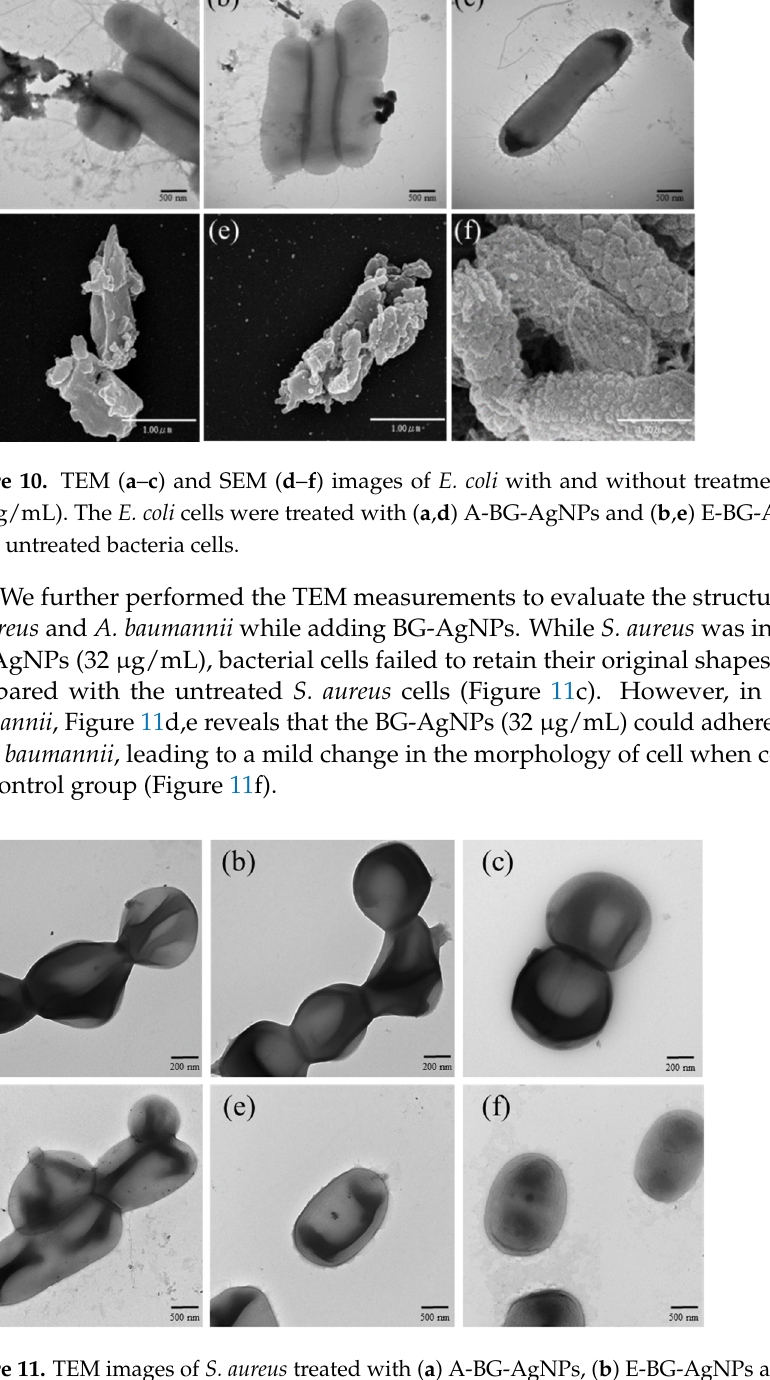
Figure 12. ( a – c ) Bright-field and ( d – f ) fluorescence images of E. coli incubated with ( a , b ) A-BG- AgNPs and ( b , e ) E-BG-AgNPs, and ( c , f ) show untreated bacteria after DCFH-DA treatment. Hemolytic evaluations were performed to determine the biocompatibility of BG ex- tract stabilized AgNPs by incubating human red blood cells (RBCs) with different concen- trations (31.25–500 µg/mL) of BG-AgNPs. Figure 13 reveals that the viabilities of the RBCs were 90.6% in the presence of 500 µg/mL of A-BG-AgNPs, which is 125- and 250-fold